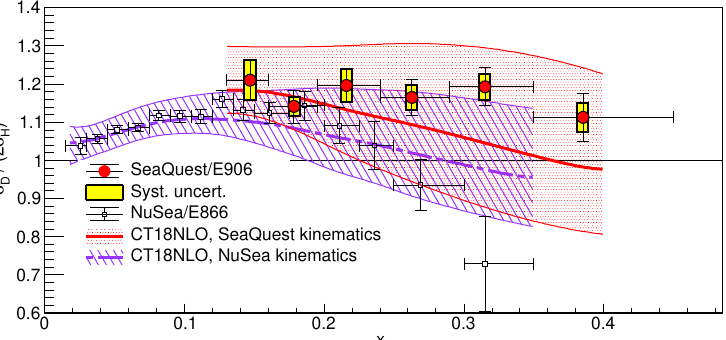
[ 7 ] . Red points with target